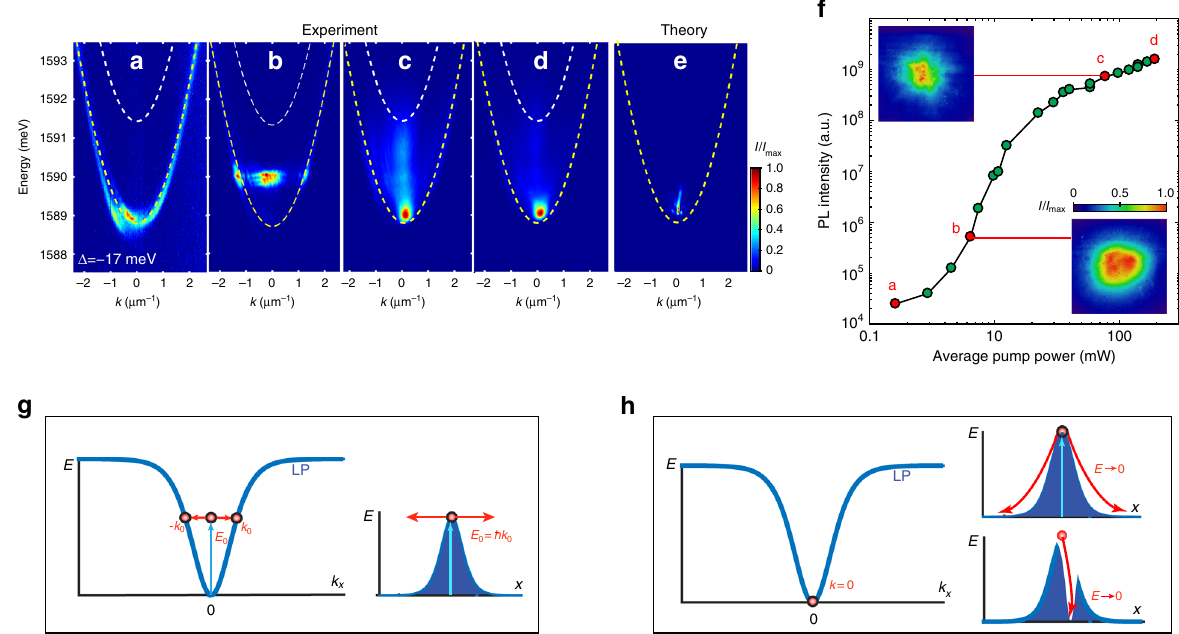
Fig. 1 Signatures of transition to condensation. a – d Dispersion of lower polaritons E ( k ≡ k x ) ensemble-averaged over 10 6 realisations of the pulsed experiment ( a ) below, b near and c , d above condensation threshold for the large negative exciton – photon detuning, Δ = − 17 meV. Panel ( e ) shows the result of numerical modelling corresponding to the conditions in d . The white (yellow) dashed curves in a – d at higher (lower) energy correspond to the cavity photon (lower polariton), respectively. f Measurements of the ensemble-averaged emission intensity below and above condensation threshold. The emission is collected and integrated over a 70 × 70 μ m detection window. Marked points correspond to the dispersion shown in a – d . Insets show ensemble-averaged real-space images of the polariton density below and above threshold in the detection window. g Schematics of the lower polariton dispersion curve, E ( k x ), and energy vs. position, E ( x ), for low excitation powers. The E ( x ) schematics illustrates ballistic expansion and condensation at k x ≠ 0 corresponding to the dispersion shown in b . h Schematics of the lower polariton dispersion curve, E ( k x ), and energy vs. position, E ( x ), for high excitation powers. The E ( x ) schematics illustrate two possible routes to condensation at k x = 0: energy relaxation with a non-depleted reservoir and reservoir depletion accompanied by energy